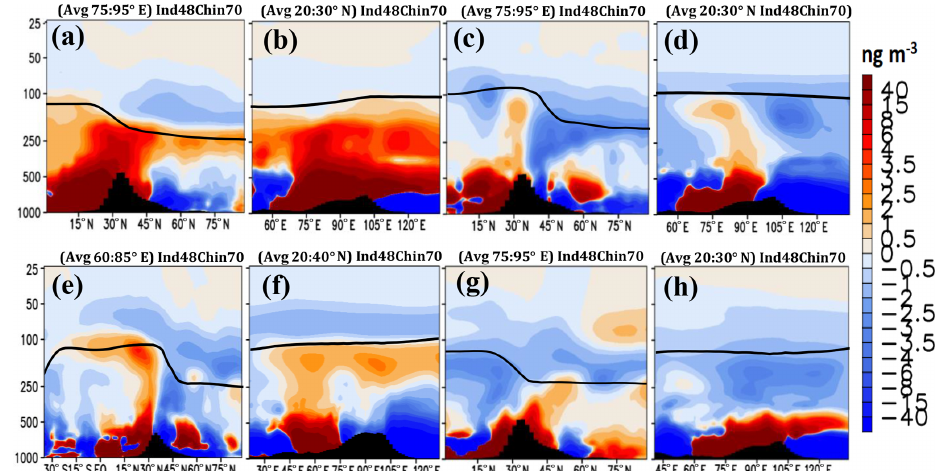
Figure 5. Vertical cross section of anomalies in sulfate aerosols (ngm − 3 ) from the Ind48Chin70-CTRL simulation for the pre-monsoon season (a) latitude–pressure section and (b) longitude–pressure section; (c) – (d) same as (a) – (b) but for the summer-monsoon season; (e) – (f) same as (a) – (b) but for the post-monsoon season; (g) – (h) same as (a) – (b) but for the winter season. The averages obtained over latitudes or longitudes are indicated in each panel. The black vertical bars indicate topography, and a black line indicates the